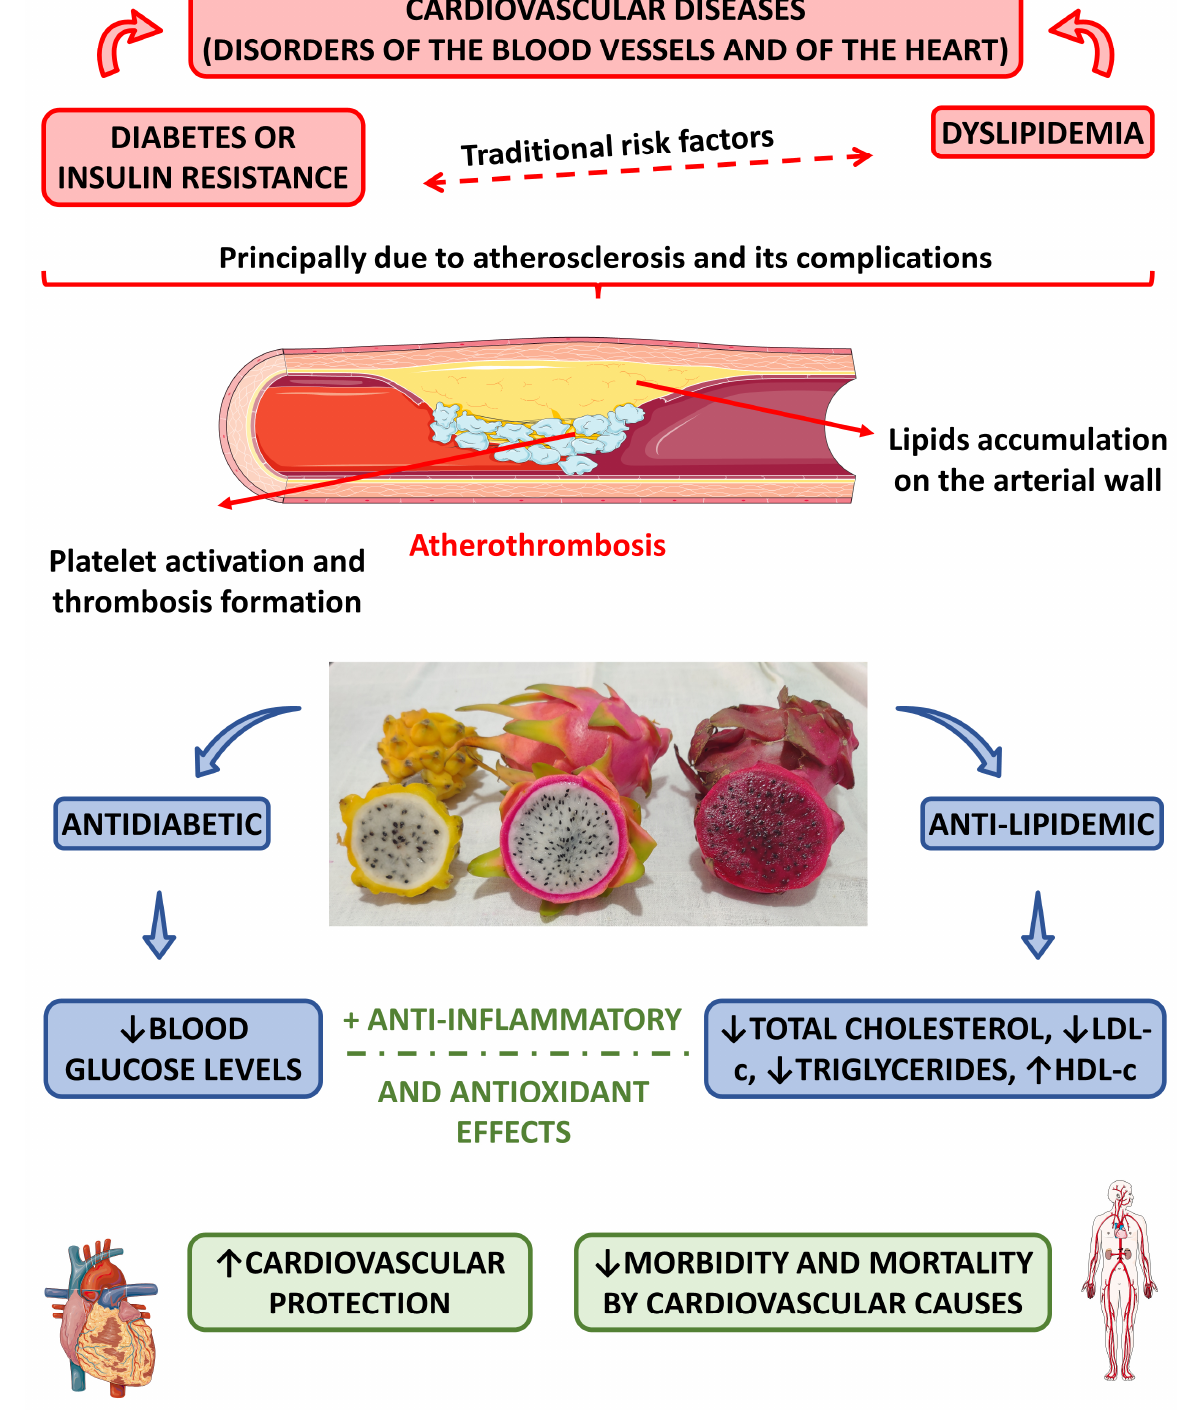
Figure 7. Cardiovascular protective effects of the Hylocereus species. ↑ —increase; ↓ —decrease; HDL-c—high-density lipoprotein cholesterol; LDL-c—low-density lipoprotein